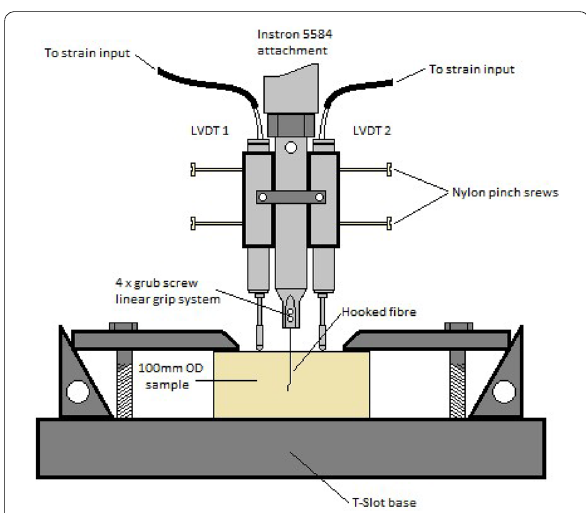
Fig. 3 Pull-out test